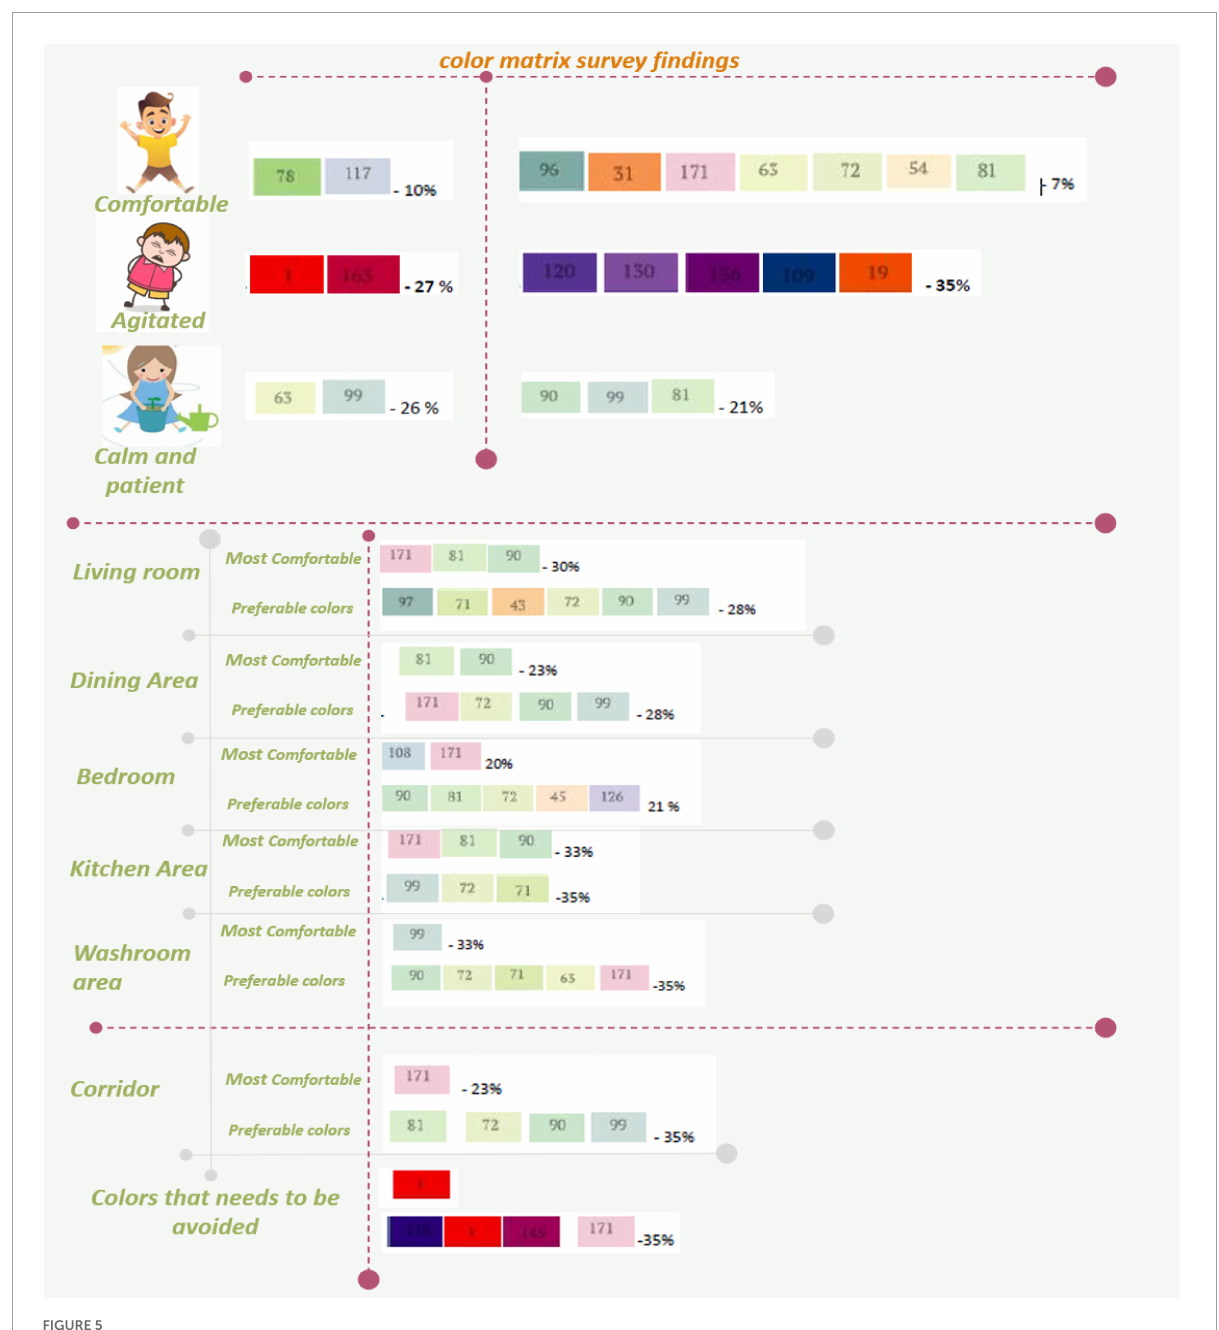
FIGURE5 Illustration of color analysis from the survey done by the color